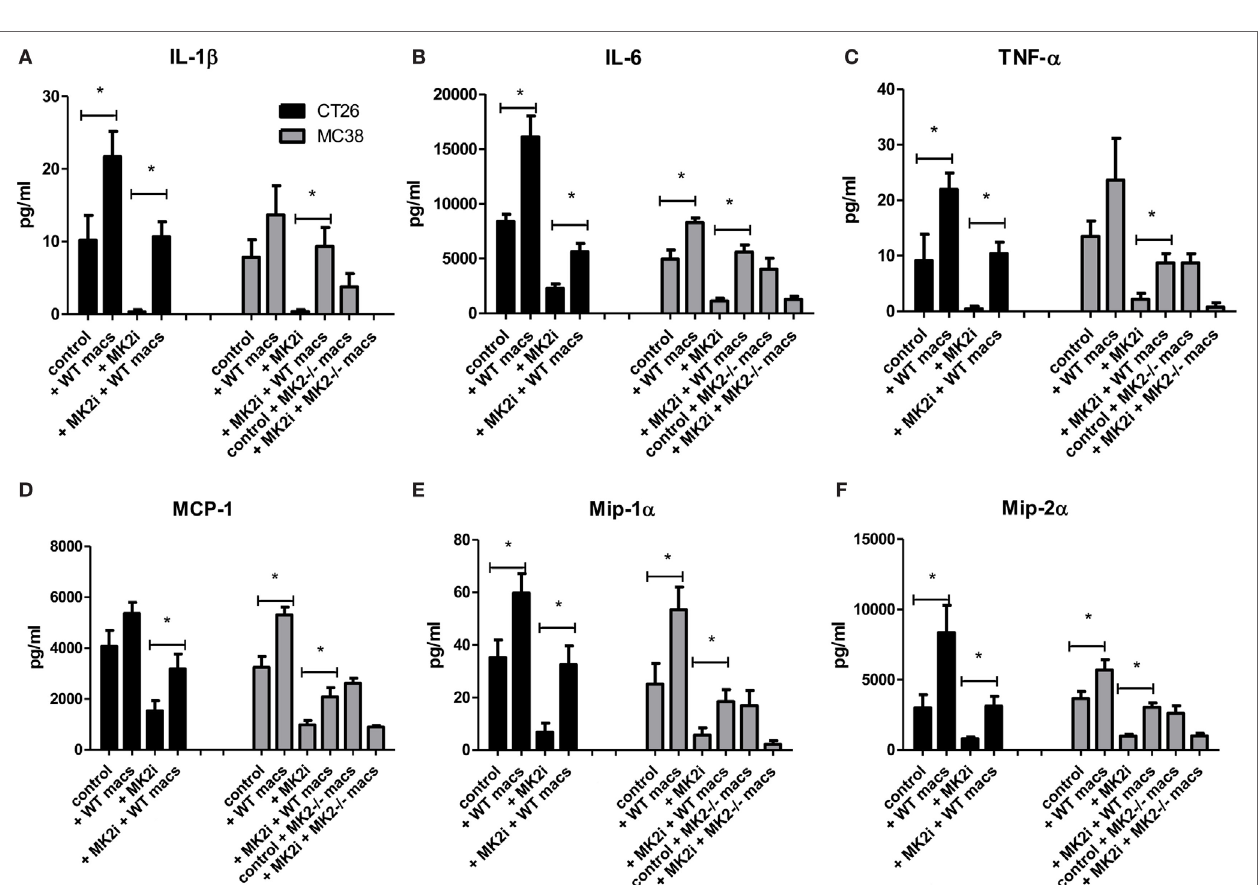
FigUre 7 | Addition of WT macrophages to MK2 inhibitor-treated tumors restores cytokine and chemokine production in vivo . CT26 and MC38 tumor supernatants produce (a) IL-1 β , (B) IL-6, (c) TNF- α , (D) MCP-1, (e) Mip-1 α , and (F) Mip-2 α , which was decreased with MK2 inhibition and restored by the addition of macrophages to tumors by multiplex cytokine array. N = 7–8, * p ≤